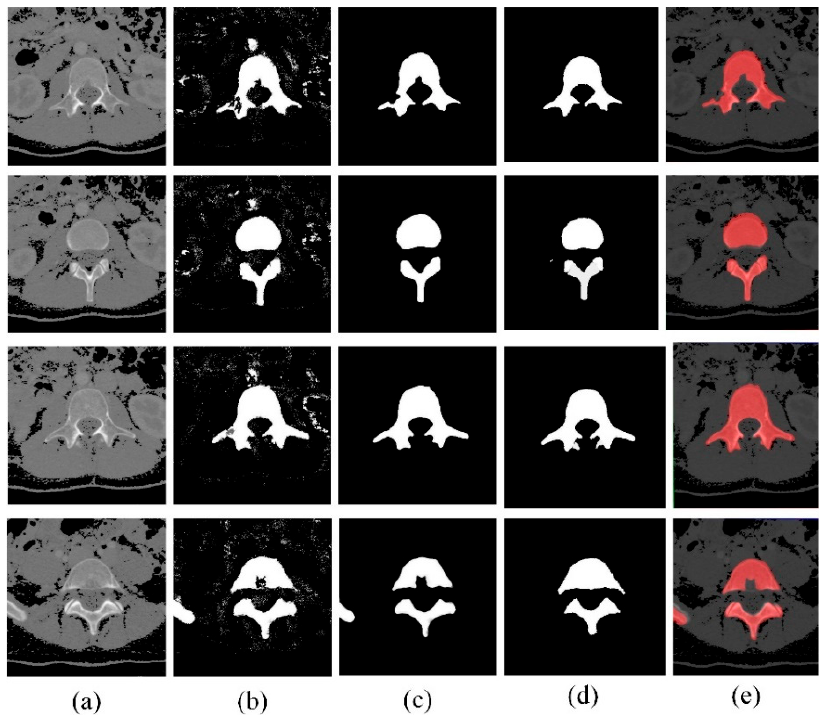
Figure 9. Segmentation results from randomly selected axial slices of test CT image 2: ( a ) raw image; ( b ) initial segmentation; ( c ) finial segmentation; ( d ) ground truth; and ( e ) segmentation superimposed on CT image.